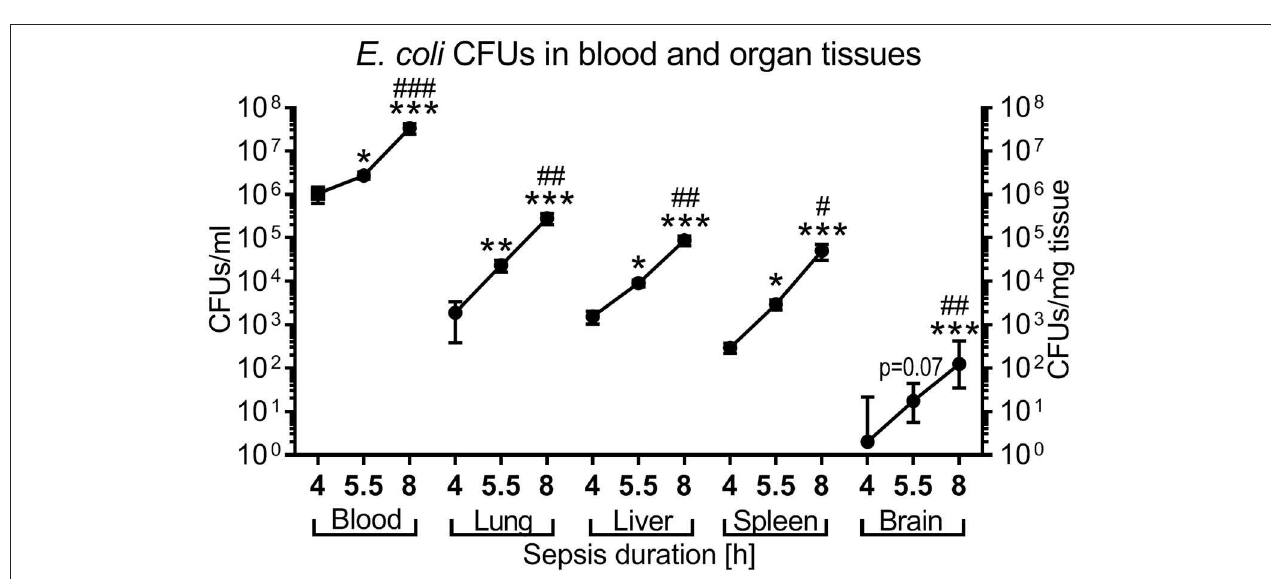
FIGURE 6 | Time-dependent E. coli bacterial growth pattern in murine neonatal sepsis. Neonatal mice < 24h old were injected IV with E. coli 10 5 CFU/g body weight. After 4h ( n = 10), 5.5h ( n = 34), and 8h ( n = 19) of incubation, mice were euthanized and blood, and homogenized organ tissue serially plated for bacterial counting. Mean ( ± SEM) or median (IQR) CFUs were plotted for each time point as indicated. Significant differences of CFU counts for each organ and blood recovered after increasing incubation periods were as follows: * p < 0.05, ** p < 0.01, *** p < 0.001 for 4 vs. 5.5h and 4 vs. 8h comparisons; # p < 0.05, ## p < 0.01, ### p < 0.001 for 5.5 vs. 8h comparisons, Kruskal-Wallis tests corrected for false discovery rate.